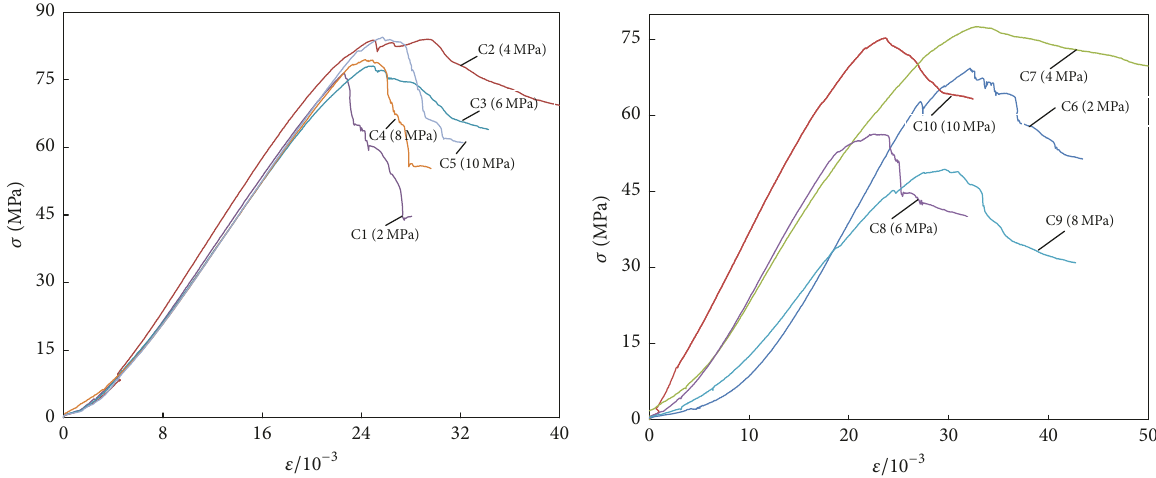
Figure 10: Static stress-strain curves of natural and 7D saturated specimens under triaxial